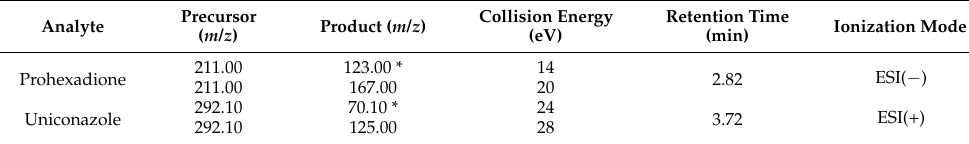
Table 5. MRM set up on mass